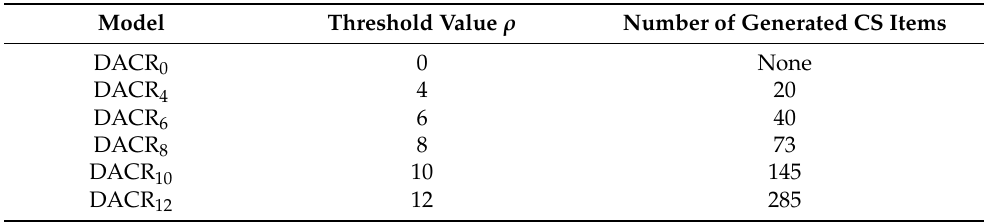
Table 7. The summary for the six DACR models.